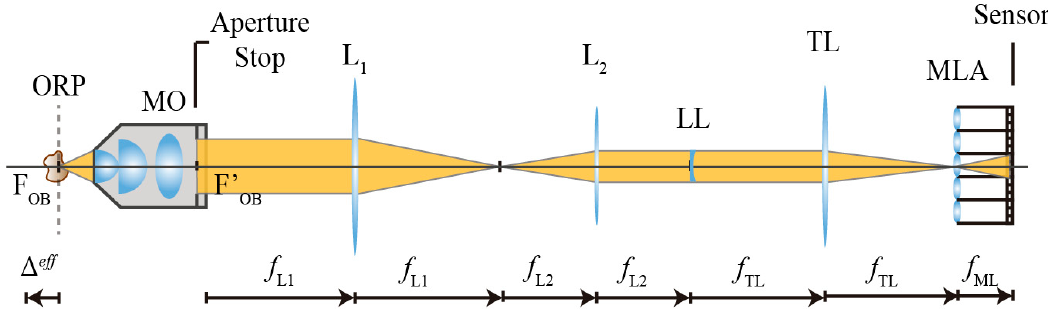
Figure 3. Scheme of an IMic as implemented in the laboratory. We used a relay system composed by two lenses of focal lengths f L1 = 150 mm and f L2 = 75 mm, respectively, and disposed of in afocal configuration. The LL is then placed at the back focal plane of L 2 .